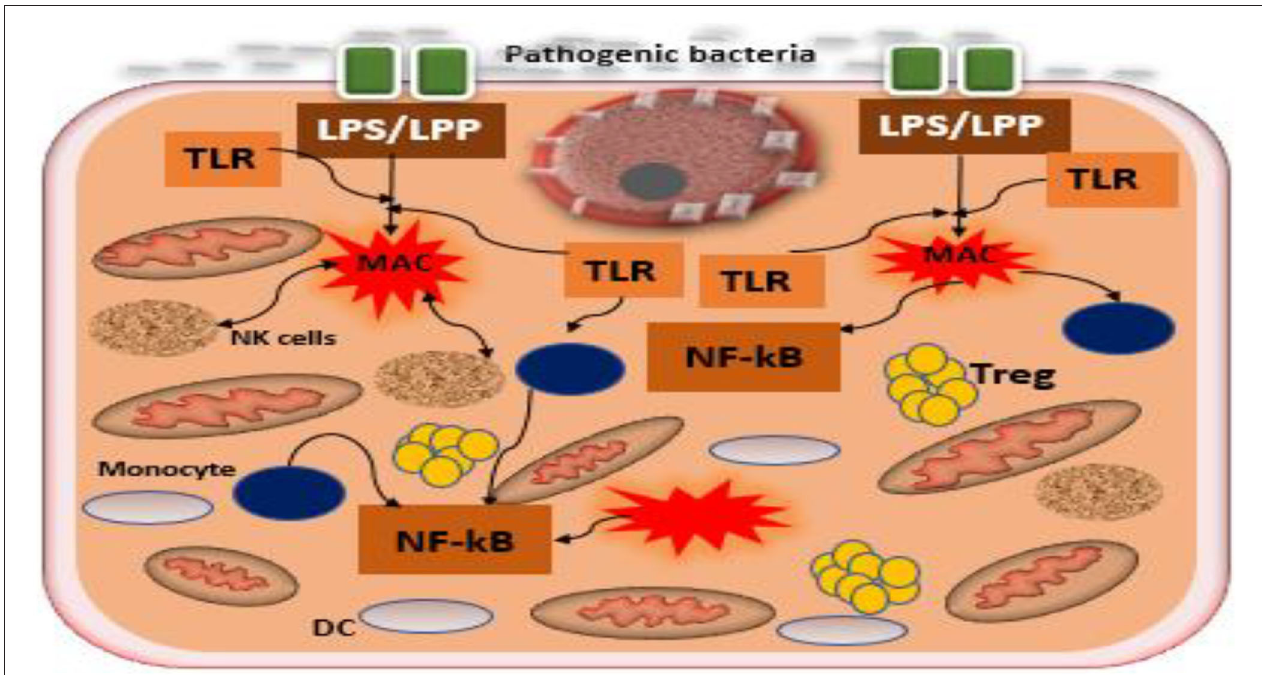
FIGURE 3 | Interaction between pathogenic bacteria and toll-like receptors of the trophoblast in the formation of inflammatory cascades. Pathogenic bacteria, including the Gram-positive and Gram-negative present at the epithelium of the uterus promote the induction of inflammatory cascades by the interactions between the bacterial products LPP/LPS and toll-like receptors, TLR2/TLR4 expressed by trophoblast. Dysbiosis of placental microbiome increases the growth of pathogenic bacteria disrupting symbiosis among microbiota, trophoblast, and immune cells in the uterus, leading to inflammatory cascades that have been recognized in the pathogenesis of PE. Tregs, T regulatory cells; TLR, toll-like receptor; DC, decidual cell; LPS, lipopolysaccharide; LPP, lipoproteins; MAC, macrophage.